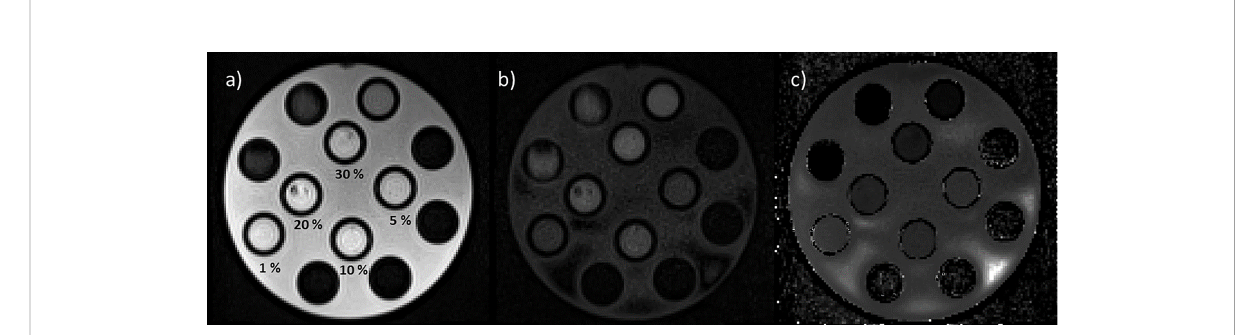
FIGURE 5 Images of the HMP acquired using diffusion sequences with b-values set to 0 s/mm 2 , 3 averages (a) and 800 s/mm2, 10 averages (b). In panel “ c ” is reported the calculated ADC map. In panel “ a ” are also reported the values of the concentrations of methylcellulose solution below the relative